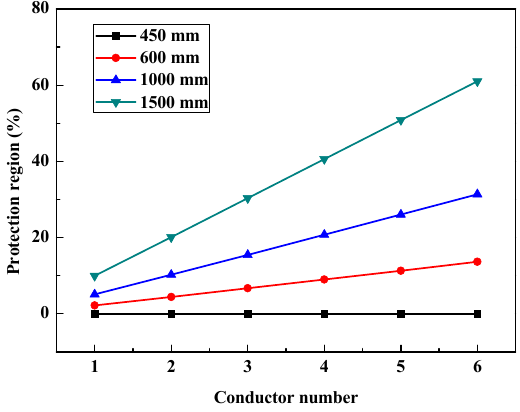
Figure 17. Influence of conductor on protection region of arcing horns.